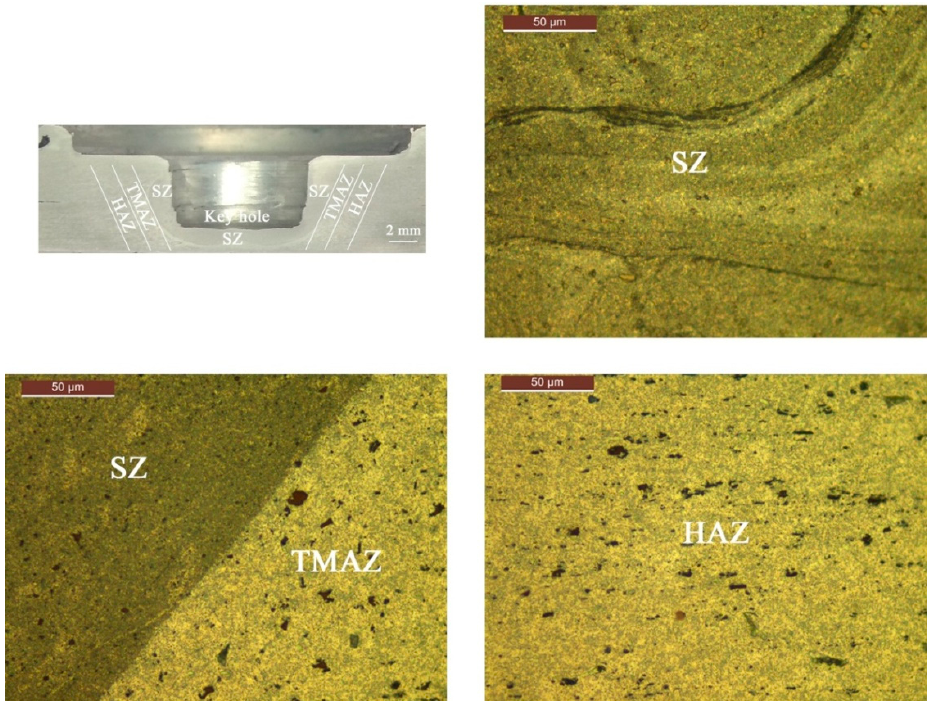
Figure 6. Optical micrographic views showing the various zones (SZ, TMAZ, and HAZ) of the AA5083/micro-SiC joints.